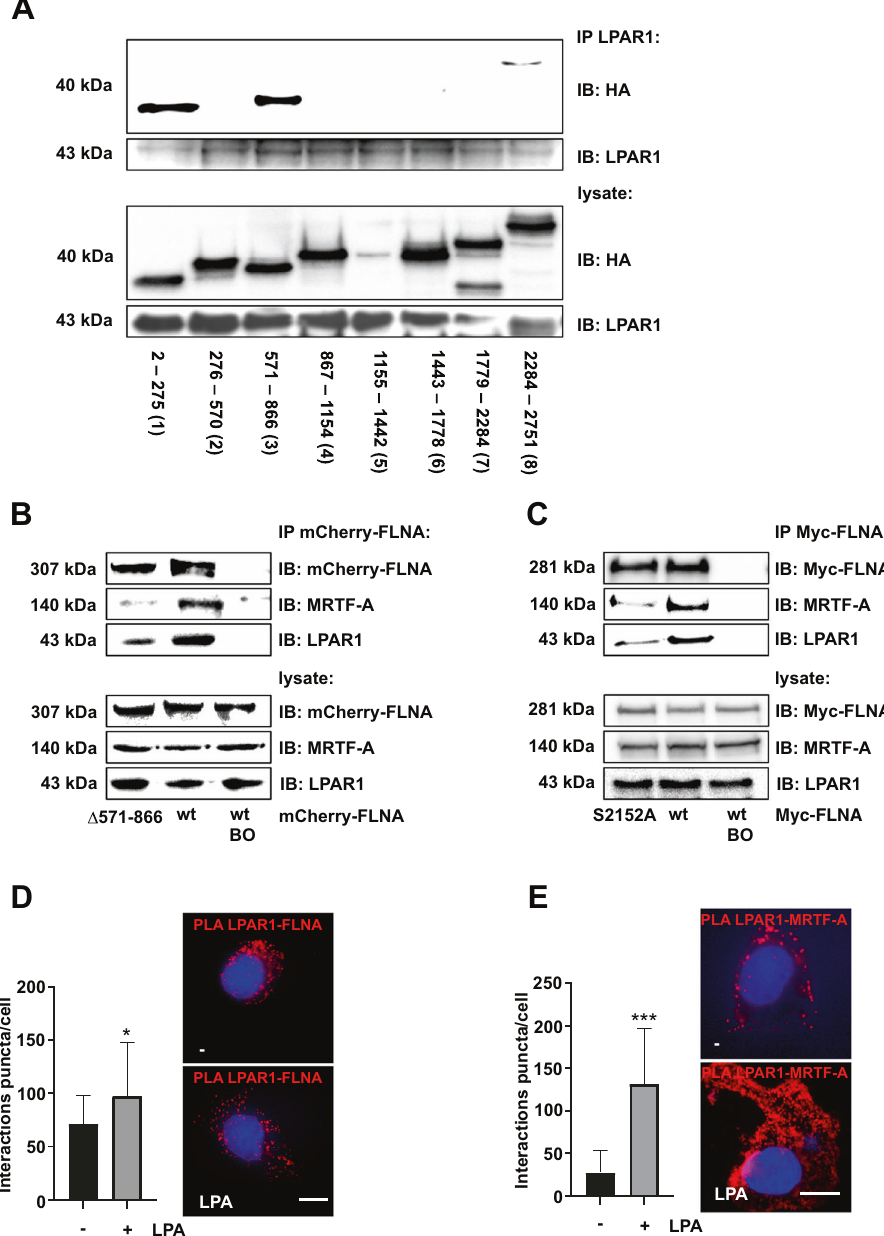
Fig. 5 Mapping of LPAR1 – FLNA interaction sites. A Immunoprecipitation (IP) in HuH7 cells transfected with different HA-FLNA fragments by using anti-LPAR1-antibody for pulldown and anti-LPAR1 and anti-HA antibodies for immunoblot (IB). HA-FLNA mutant 1-8: 1: FLNA a.a. 2-275; 2: FLNA a.a. 276-570; 3: FLNA a.a. 571-866; 4: FLNA a.a. 867-1154; 5: FLNA a.a. 1155-1442; 6: FLNA a.a. 1443-1778. 7: FLNA a.a. 1779-2284; 8: FLNA a.a. 2285-2751. B Immunoprecipitation (IP) for mCherry-FLNA in HuH7 cells expressing mCherry-FLNA or mCherry-FLNA Δ 571-866 and immunoblot (IB) for mCherry-FLNA, MRTF-A, and LPAR1. BO: Dynabeads-only control, without antibody. C Immunoprecipitation (IP) for Myc- FLNA in HuH7 cells expressing Myc-FLNA or Myc-FLNA S2152A and immunoblot (IB) for Myc-FLNA, MRTF-A, and LPAR1. BO: Dynabeads-only control, without antibody. D Quanti fi cation of proximity ligation assay for endogenous LPAR1 and FLNA in HepG2 cells, which were stimulated with LPA (20 µM) for 30 min or remained untreated. Scale bar: 10 µm. Values are mean ± SD; ( n = 3); * p < 0.05. E Quanti fi cation of proximity ligation assay for endogenous LPAR1 and MRTF-A in HepG2 cells, which were stimulated with LPA (20 µM) for 30 min or remained untreated. Scale bar: 10 µm. Values are mean ± SD; ( n = 3); *** p < 0.001. in HuH7 cells upon cleavage by calpain proteases and is expressed cell extracts with LPAR1 antibody revealed that the N-terminal in HuH7 cells, as determined by calpain inhibitor III treatment (Fig. actin-binding domain (FLNA-ABD; 2-275 (1)) and the MRTF-A- S4B). To further delineate the importance of the MRTF-A binding binding domain (FLNA 571-866 (3); [15]) of FLNA strongly interact domain, we engineered an internal deletion of FLNA amino acids with LPAR1 (Fig. 5A). In addition to these two prominent binding 571 – 866. Immunoprecipitation of HuH7 cell extracts with an sites, FLNA has a third weaker binding site (FLNA 2284-2751 (8)) in antibody against the mCherry-tag and detection with mCherry-, the C-terminus. A similar 90 kDa C-terminal fragment is generated